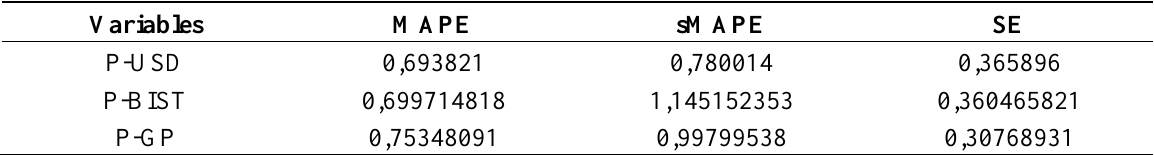
Table 2. Some symmetry measures prior to the financial crisis with the result of the second ANN output variables.